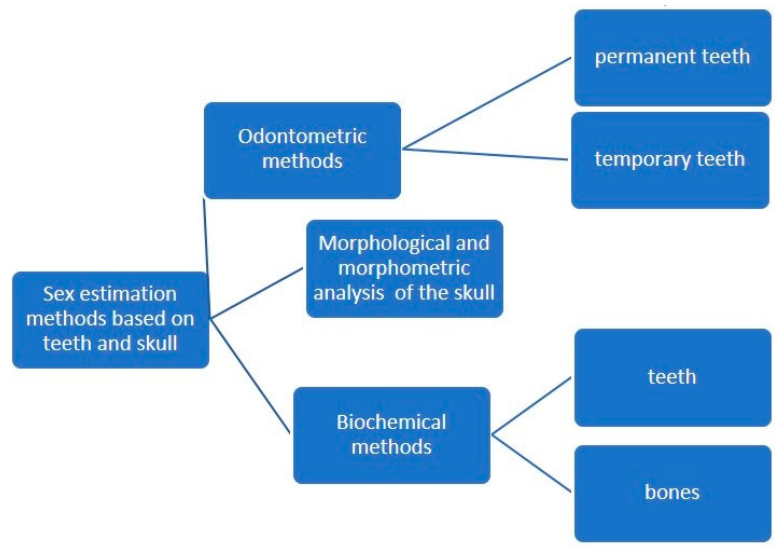
Figure 1. Odontological and cranial sex estimation methods (overview).